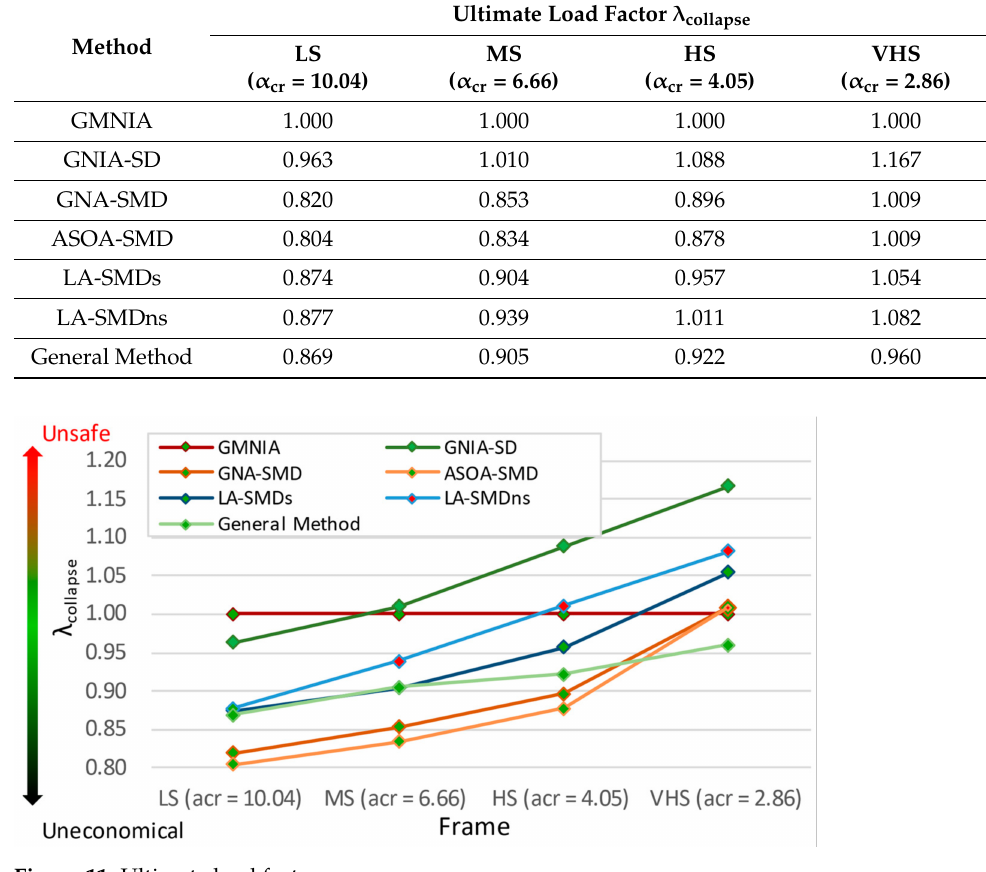
Table 3. Ultimate load factors.